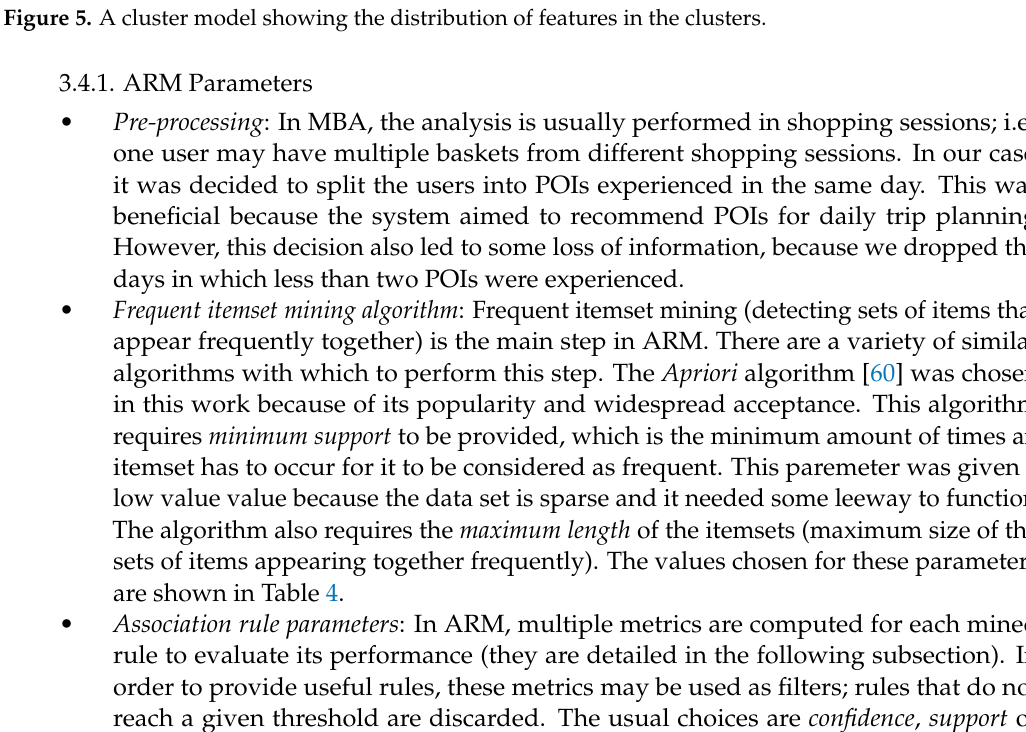
Figure 5. A cluster model showing the distribution of features in the